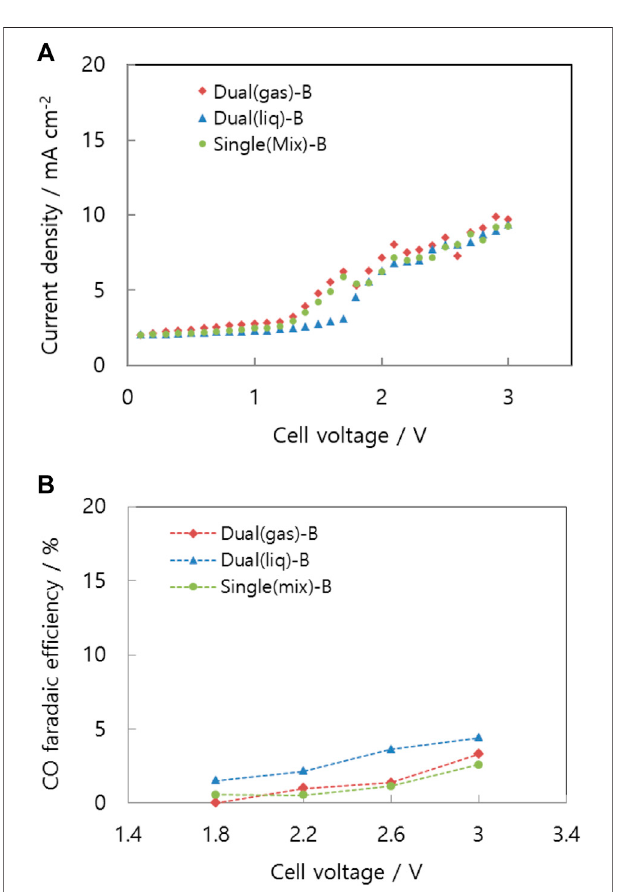
FIGURE 9 | (A) Voltage-current curve and (B) CO faradaic ef fi ciency of differently structured cells: Dual (gas)-B, Dual (liq)-B, and Single (mix)-B.